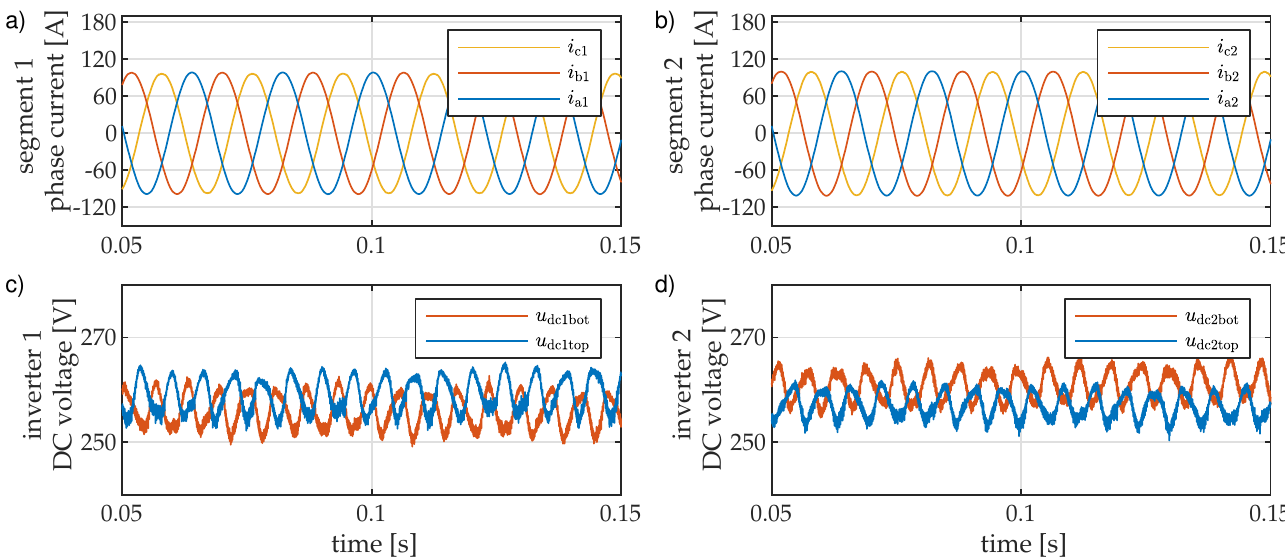
Figure 20. DC circuit analysis in single-inverter configuration—experimental results, ( a ) inverter 1 output current, ( b ) inverter 2 output current, ( c ) inverter 1 DC voltages, ( d ) inverter 2 DC voltages.